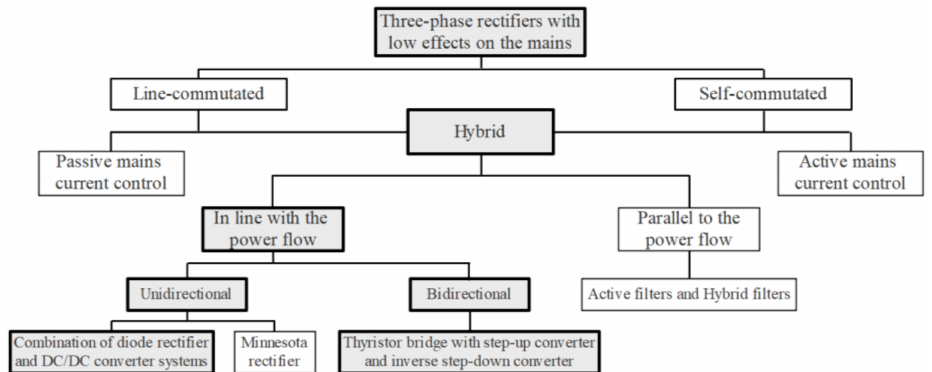
Figure 1. Classification of three-phase rectifiers with reduced harmonic